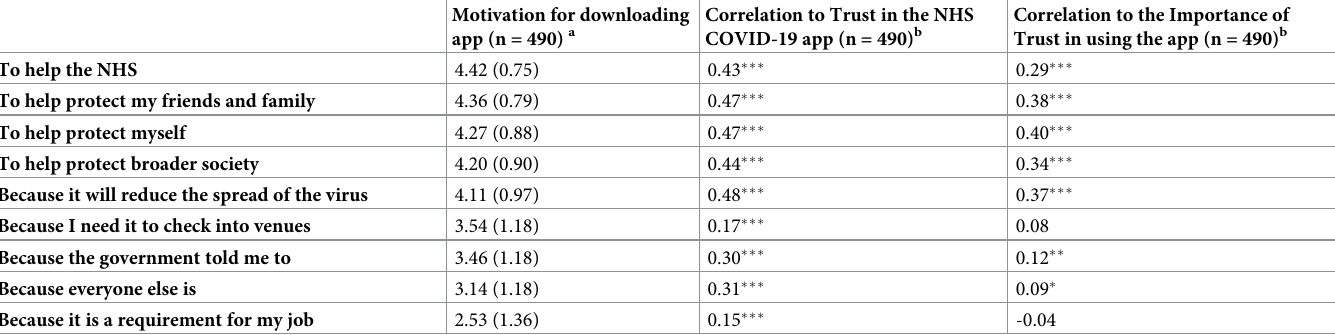
Table 3. Reasons for downloading the NHS COVID-19 app, and their relationship to trust.